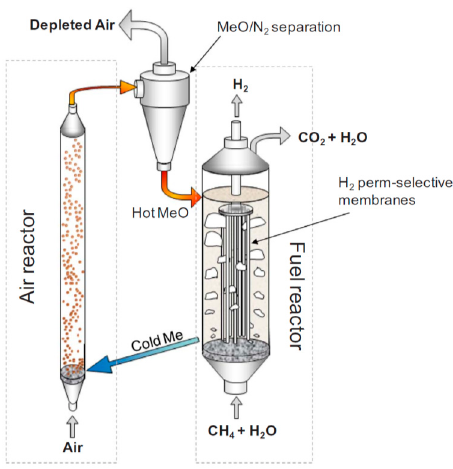
Figure 11. Schematic of the Membrane Assisted Chemical Looping Reactor (MA-CLR) system reported from [39].